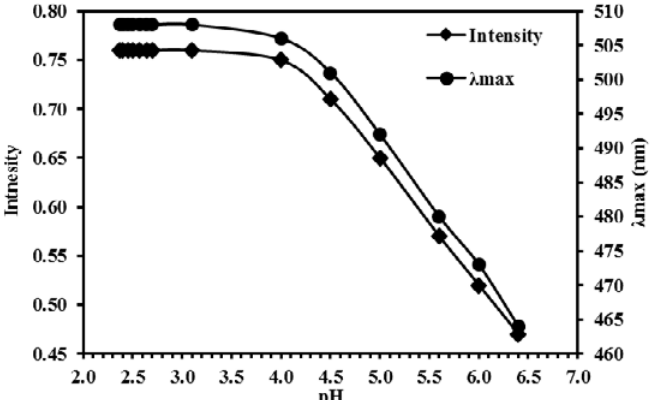
= 464 nm) for a 6.5 ppm aqueous solution of methyl max orange with pH.